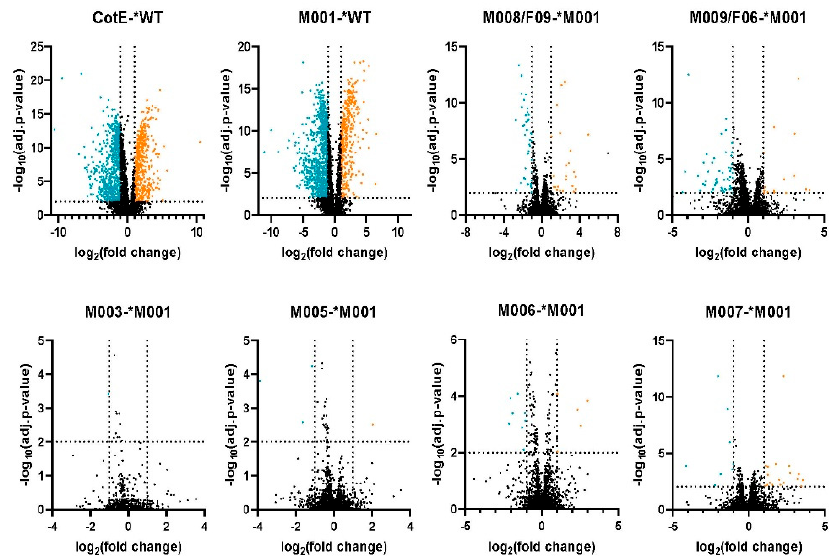
Figure 2. Volcano plots of t-test proteomes between spores of different strains. * denotes control group. The orange dots represent significantly up-regulated proteins, and blue dots indicate significantly down-regulated proteins compared with the control group. The vertical dotted lines indicate two-fold change. The horizontal dotted line represents p = 0.01.